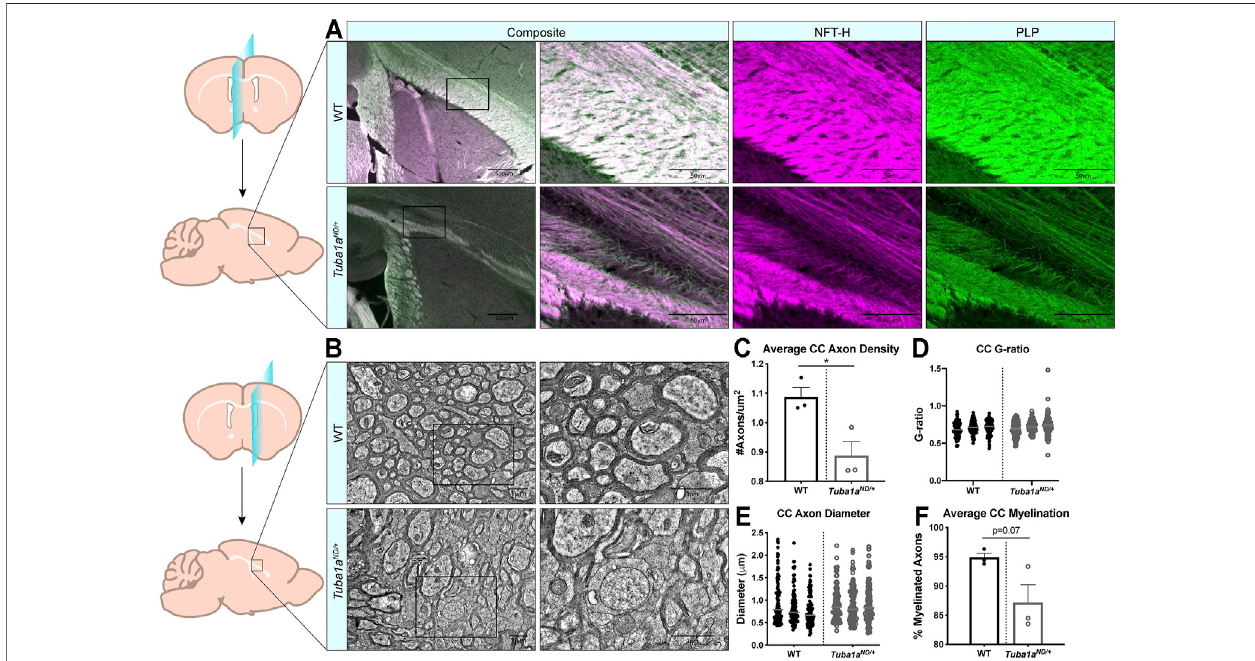
FIGURE 4 | Axon density is reduced by Tuba1a ND/+ in midline corpus callosum. (A) Sagittal brain sections at midline from wild-type (top) and Tuba1a ND/+ (bottom) brains stained with neuro fi lament-heavy (NFT-H; magenta) to label axons, and proteolipid protein (PLP; green) to label myelin. Images were taken at × 4 (left) and × 20 (right) magni fi cation with 500 and 50 μ m scale bars, respectively. (B) Electron microscopy (EM) images of sagittal wild-type (top) and Tuba1a ND/+ (bottom) sections of corpus callosum 2 mm adjacent to midline. Enlarged regions on right are denoted by boxes, scale bar is 1 μ m. (C) Scatter plot representing axon density of wild- typeand Tuba1a ND/+ axonsinanalyzedEMimages.Datapointsrepresentaveragevaluesforeachanimal( n (cid:1) 6regionscontainingsametotalarea; p (cid:1) 0.03). (D) Scatter plot of G-ratio measurements for wild-type and Tuba1a ND/+ axons. Data points represent individual myelinated axons and are clustered by animal (N (cid:1) 3 mice, n (cid:1) 100 axons; p (cid:1) 0.34). (E) Scatter plot ofaxon diameters inwild-type and Tuba1a ND/+ corpuscallosum by EM. Only those axonscaptured in cross section were assessed for diameter, as skewed axons provide inaccurate measurements. Data points represent individual axons and are clustered by animal ( n (cid:1) 100; p (cid:1) 0.14). (F) Scatter plot representing the average percent of myelinated axons per animal in wild-type and Tuba1a ND/+ corpus callosum. Six regions containing the same total area were assessed ( n (cid:1) 6; p (cid:1) 0.07). Statistical differences between means of wild-type and Tuba1a ND/+ datasets were assessed by t test, with * p < 0.05.